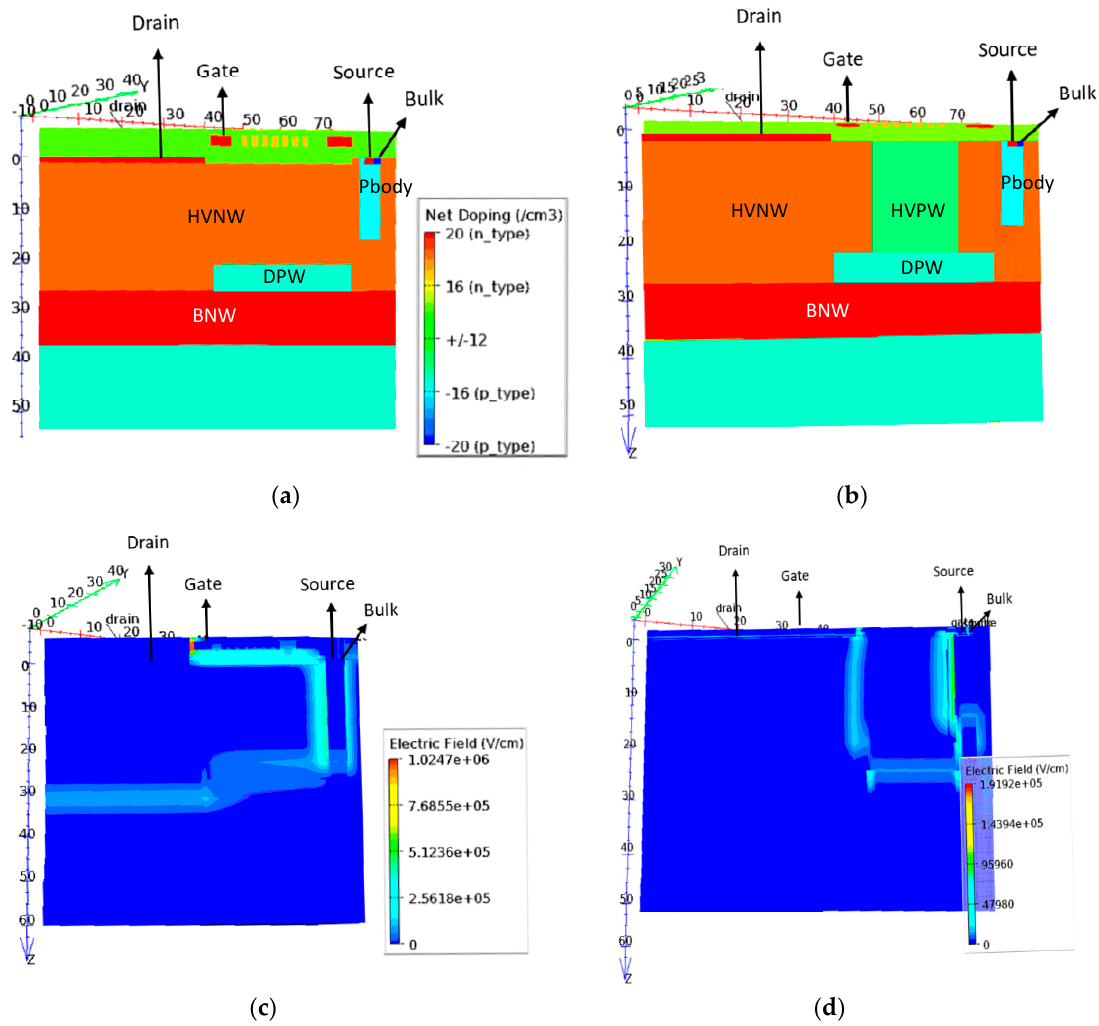
Figure 11. ( a ) 3-D thin-slice structure of the nLDMOS ref. device, ( b ) 3-D thin-slice structure of the nLDMOS-SJ M8_X20 device, ( c ) electric field distribution of the nLDMOS ref. device, and ( d ) electric field distribution of the nLDMOS-SJ M8_X20 device.